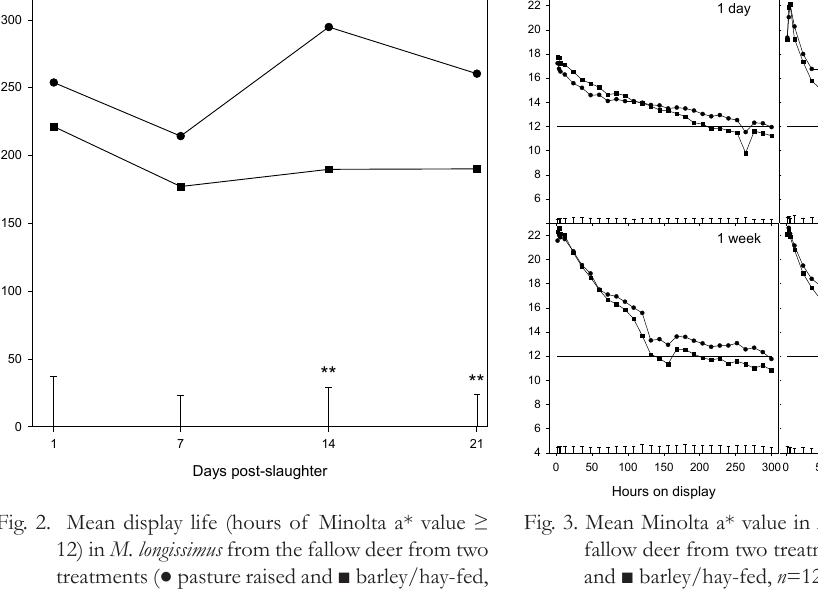
Fig. 3. Mean Minolta a* value in M. longissimus from the fallow deer from two treatments (● pasture raised and ■ barley/hay-fed, n =12 in each group) includ- ed in the study, measured after one day post mor- tem , after opening the vacuum bag after 1, 2 and 3 weeks (0-300 h of display) of refrigerated storage (+ 2 °C), with error bars indicating standard error of difference (S.E.D). ation (from a bright red to a brownish red colour) of meat in retail display conditions (Liu et al .,